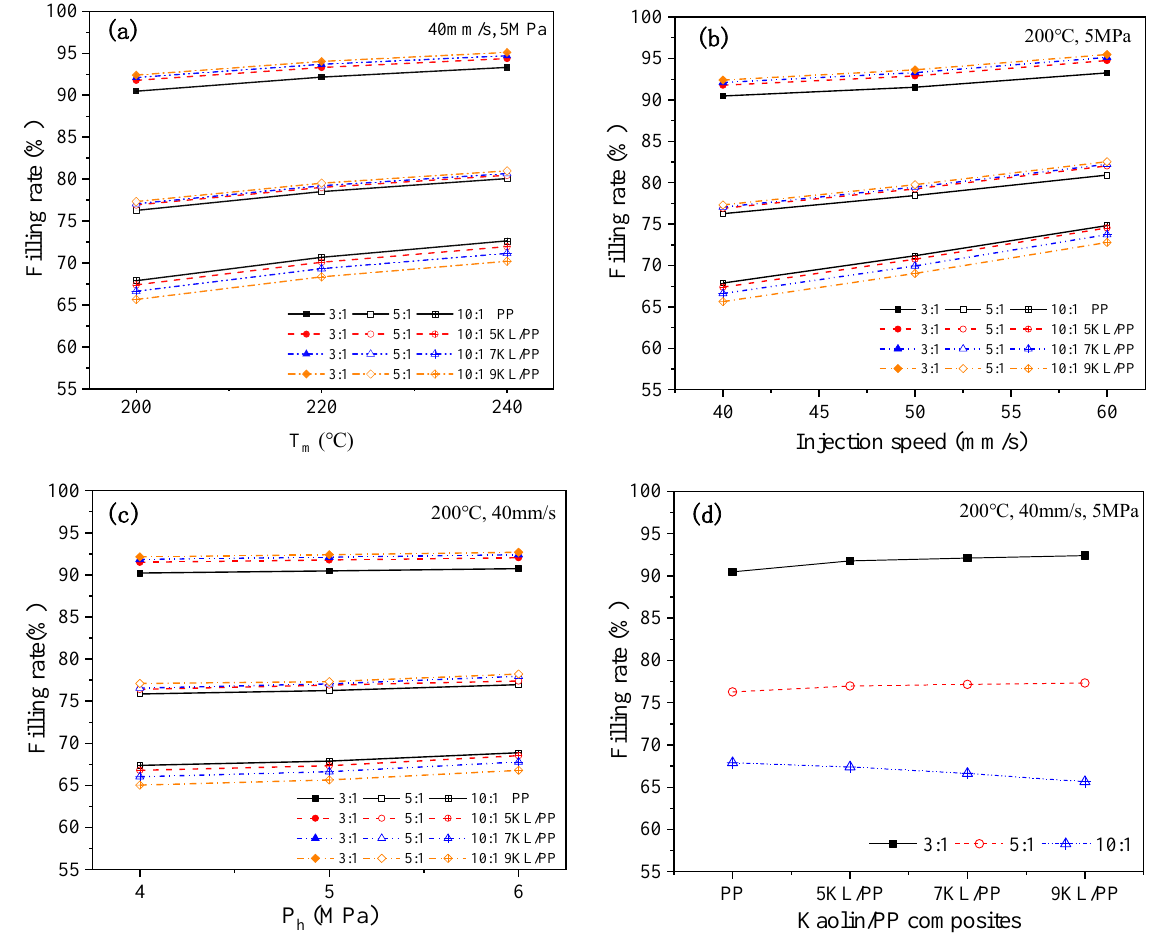
Figure 4. Effects of the ( a ) melt temperature, ( b ) injection speed, ( c ) hold pressure, and ( d ) kaolin content on the filling rate of microgrooves.